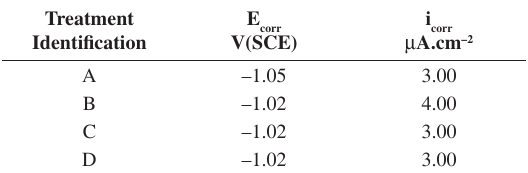
Table 2. Values of E treatment.